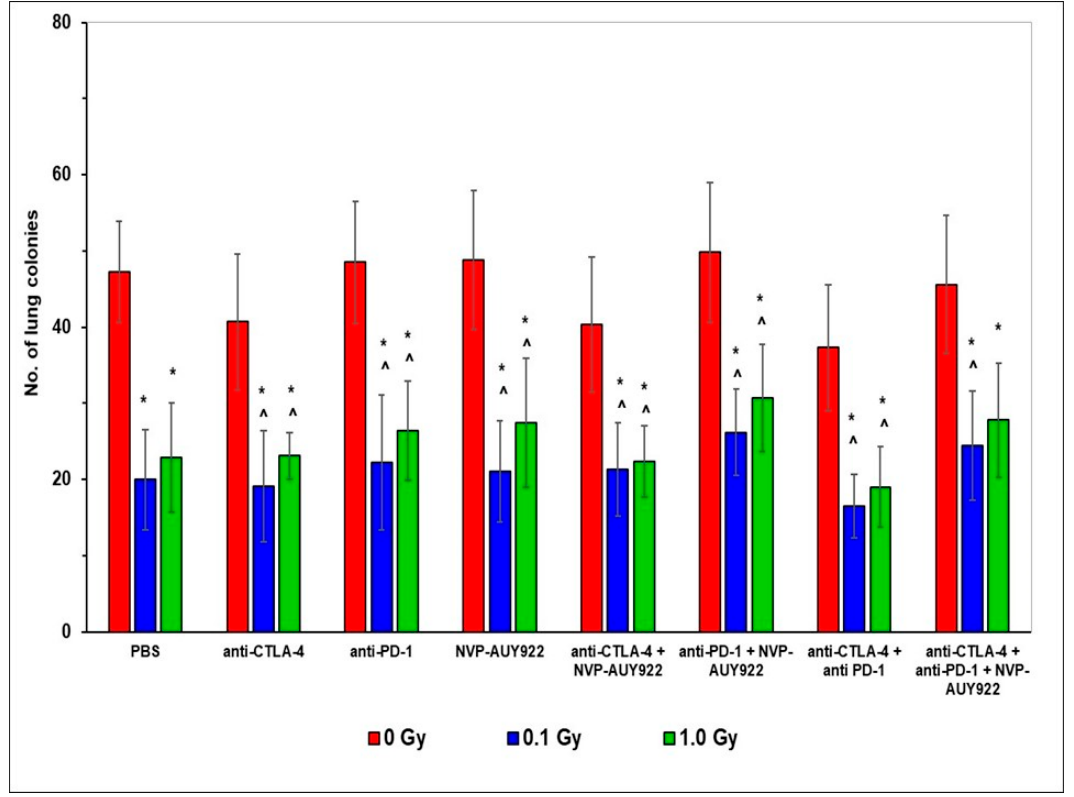
Figure 1. Tumor colonies in the lungs of C57BL/6 mice intravenously (i.v.) injected with Lewis lung carcinoma (LLC1) cells and treated with blockers of the immune checkpoints and/or heat shock protein 90 (HSP90) combined with whole-body irradiations (WBI) at total doses of 0.1 and 1.0 Gy. Mean values ± SD obtained from experiments conducted on ten mice per group are presented. * indicates statistically significant ( p < 0.05) difference from the results obtained in the sham-exposed mice injected with PBS; ˆ indicates statistically significant ( p < 0.05) difference from the results obtained in the sham-exposed mice injected with the same inhibitory